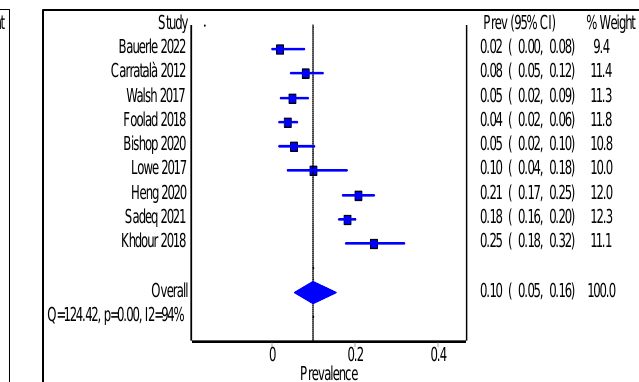
Figure 5. Prevalence of 30-day readmission within the inpatient setting in non-intervention and intervention groups.